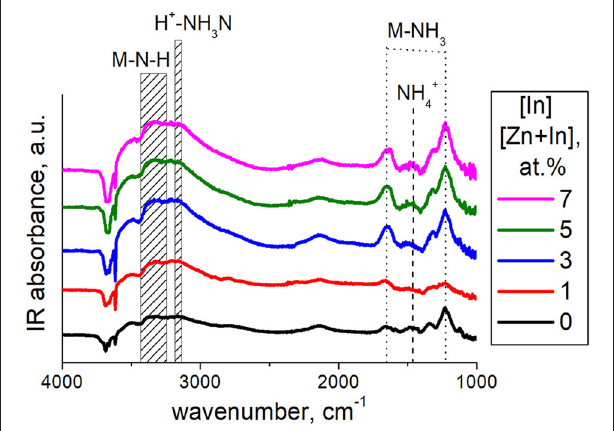
FIGURE 6 | DRIFT spectra of ZnO and ZnO/In 2 O 3 samples exposed to NH 3 (200 ppm) at room temperature.